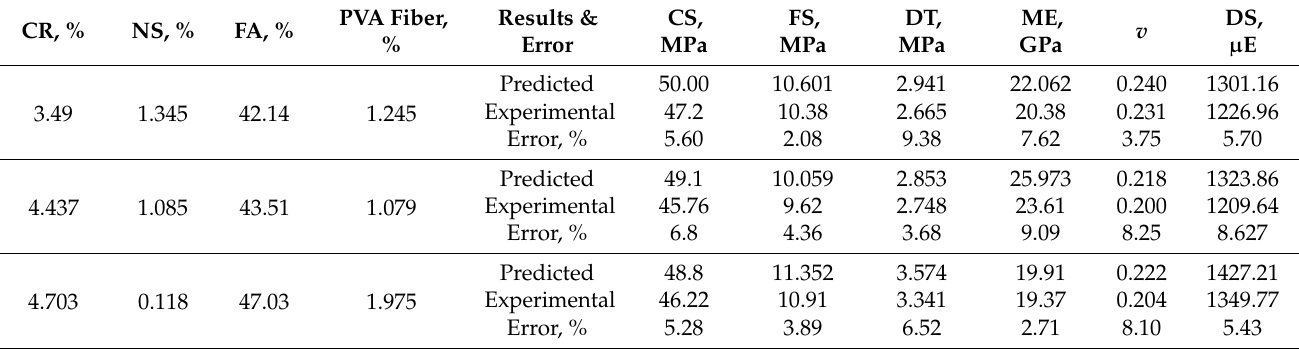
Table 10. Validation of the experimental and predicted